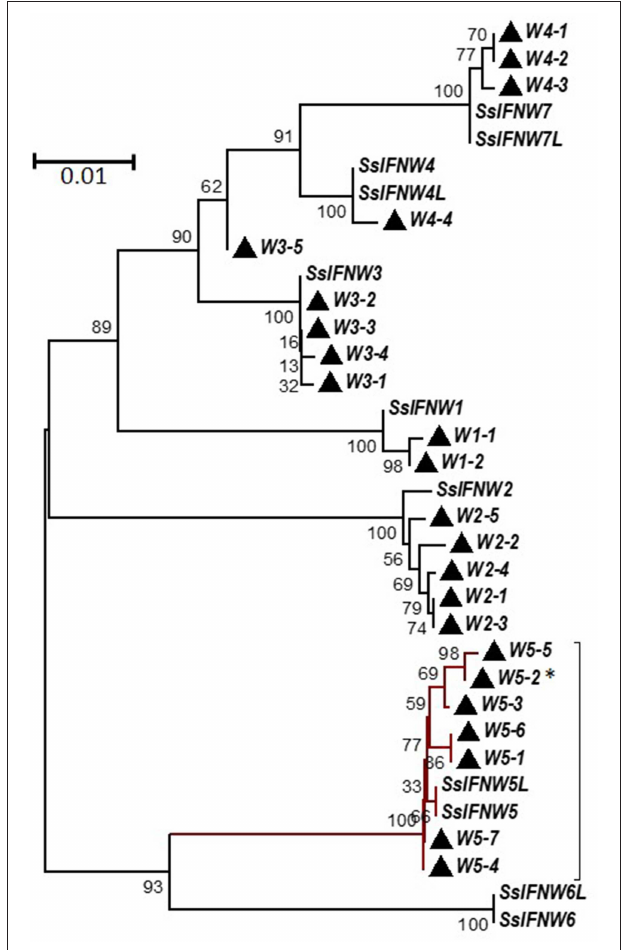
FIGURE 3 | Phylogenetic relationships of porcine IFN- ω genes (SsIFNW1-7) and identified genomic polymorphisms (Ws). SsIFNW1-7 represent seven original identifications of IFN- ω genes, of which they share < 95% sequence identity among each other. SsIFNW4L, 5L, 6L, and 7L are nearly identical duplicates of SsIFNW4-7, respectively; they are further annotated from current swine genome assembly (Sscorfa10.2). All genomic polymorphisms generally have only one to several nucleotide mutations and are clustered with their parental SsIFNW genes in the same branches. Note, more SsIFNW5 polymorphisms have been identified, and they exert diverse antiviral activity as partly shown in Figure 9 . The associated taxa clustered together in the bootstrap test (1,000 replicates) are shown next to the branches. Evolutionary analyses were conducted with MEGA6 (http://www.megasoftware.net/). *Primary IFN-W5 sequence used for activity